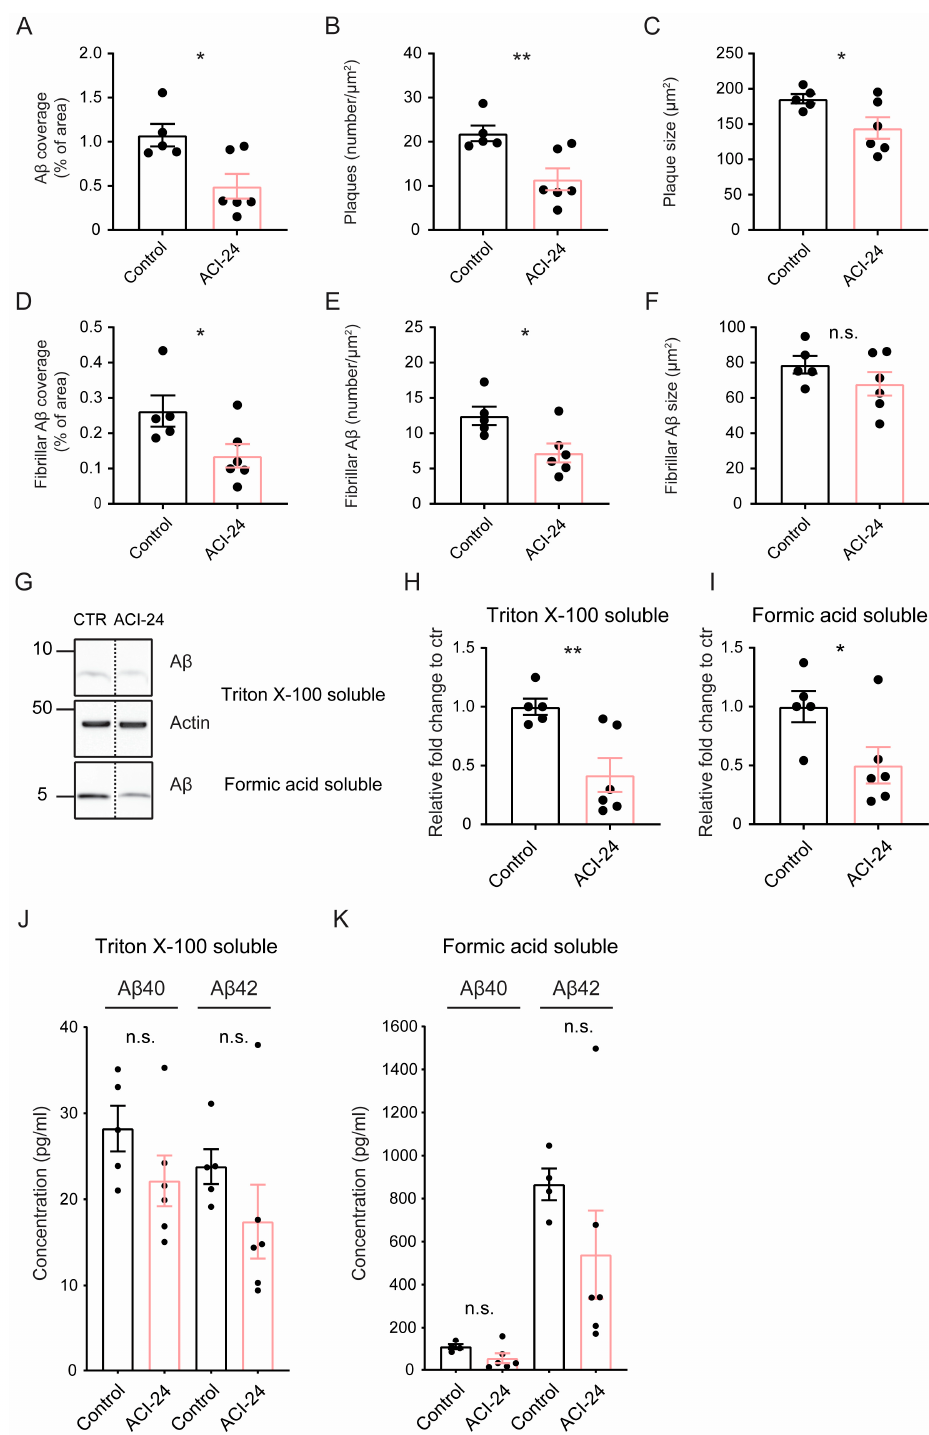
Figure 2. ACI-24 effectively reduces A β pathology in the offspring generated by the transgenic mother. Statistical analysis of 5 control and 6 ACI-24 vaccinated mice (transgenic mother offspring) for A β plaque coverage ( A ), number ( B ) and size ( C ) and fibrillar A β plaque coverage ( D ), number ( E ) and size ( F ). Representative images ( G ) and quantifications ( H , I ) of Western blot analysis of Triton X-100 soluble and formic acid soluble A β . Of note, representative samples ( G ) were not loaded next to each other, but on the same membrane. Therefore, they are separated by the dashed line. ACI-24 vaccination leads to significant reduction of A β in Triton X-100 soluble and formic acid soluble fractions. β -actin represents the loading control. ELISA analysis of Triton X-100 soluble ( J